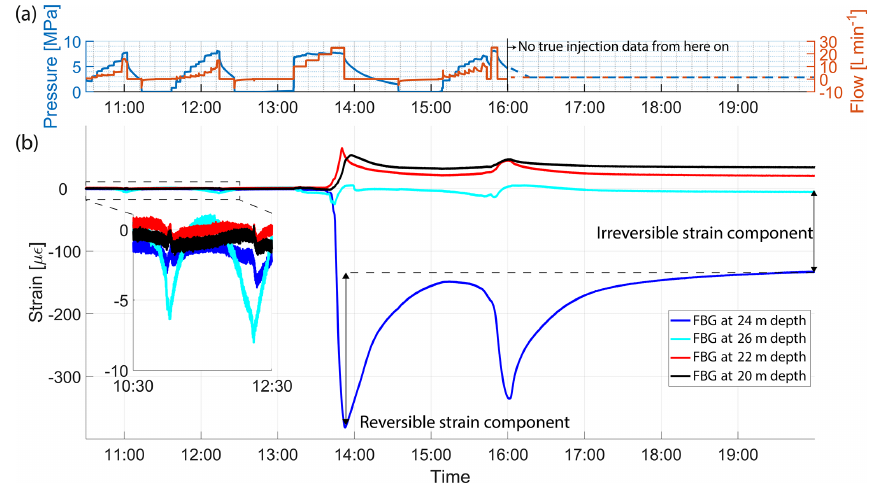
Figure 12. (a) Injection protocol during the stimulation experiment of interval HS4 with interpolations as a dashed line after the experiment. (b) Strain records at four neighboring FBG sensor locations in FBS2 during HS4. The inset shows the stains at an expanded scale during the first two